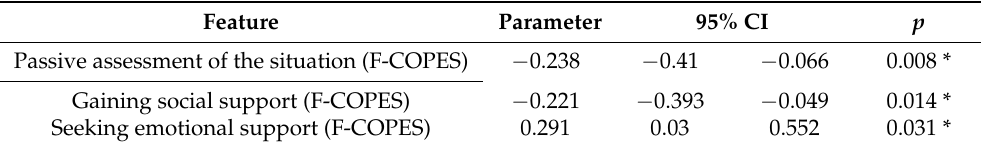
Table 8. Multivariate analysis of the impact of independent variables on emotional well-being (FQOL) assessed by children and adolescents from the control group. Passive assessment of the situation